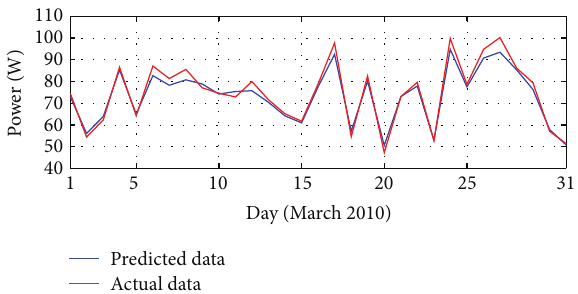
Figure 14: Results of real data and GRNN for March 2010.